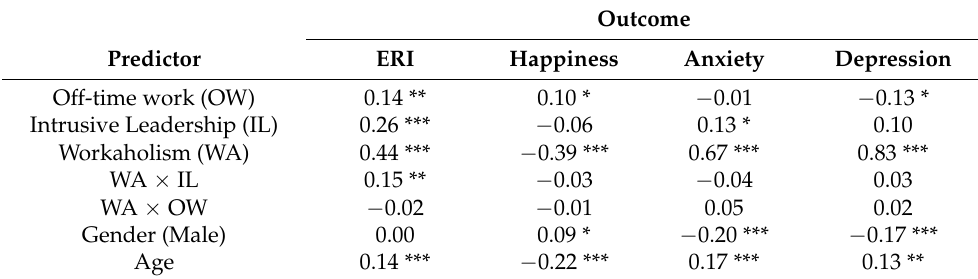
Table 2. Standardized parameter estimates for the structural model of the structural equation model in Figure 1.